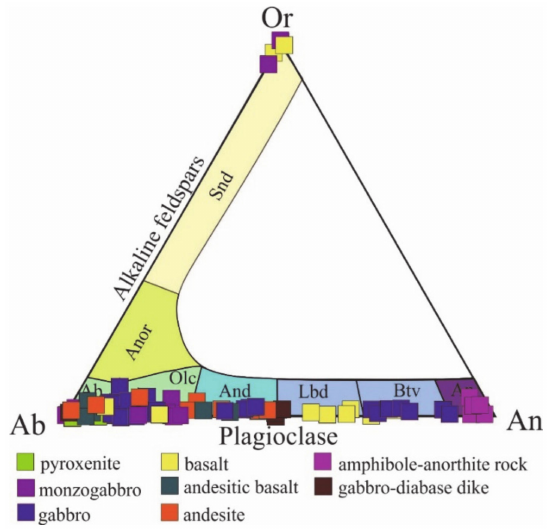
Figure 9. A nomenclature of the USM plagioclase [51].